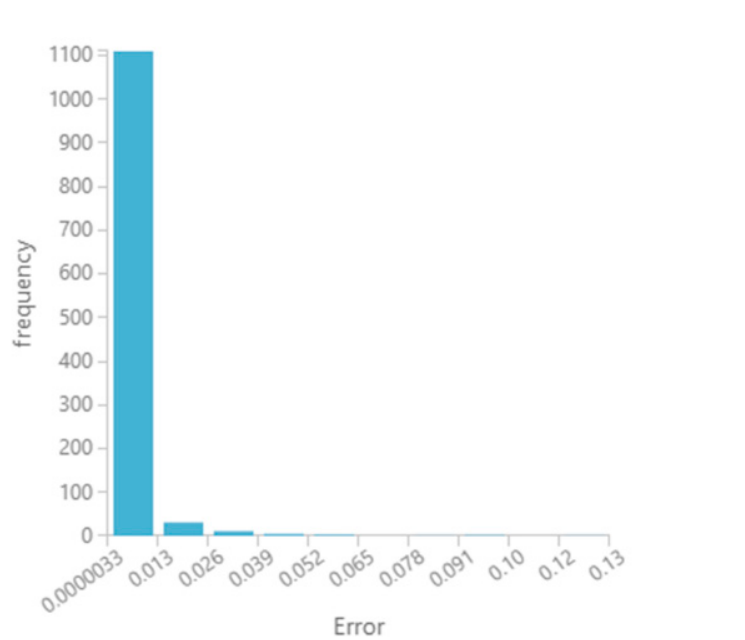
Figure 6 . Scatter plot comparing the predicted values of the dc/dt using the neural network method with the actual values of dc/dt by using the two features of total oxygen flow and lance height in the pilot dataset.